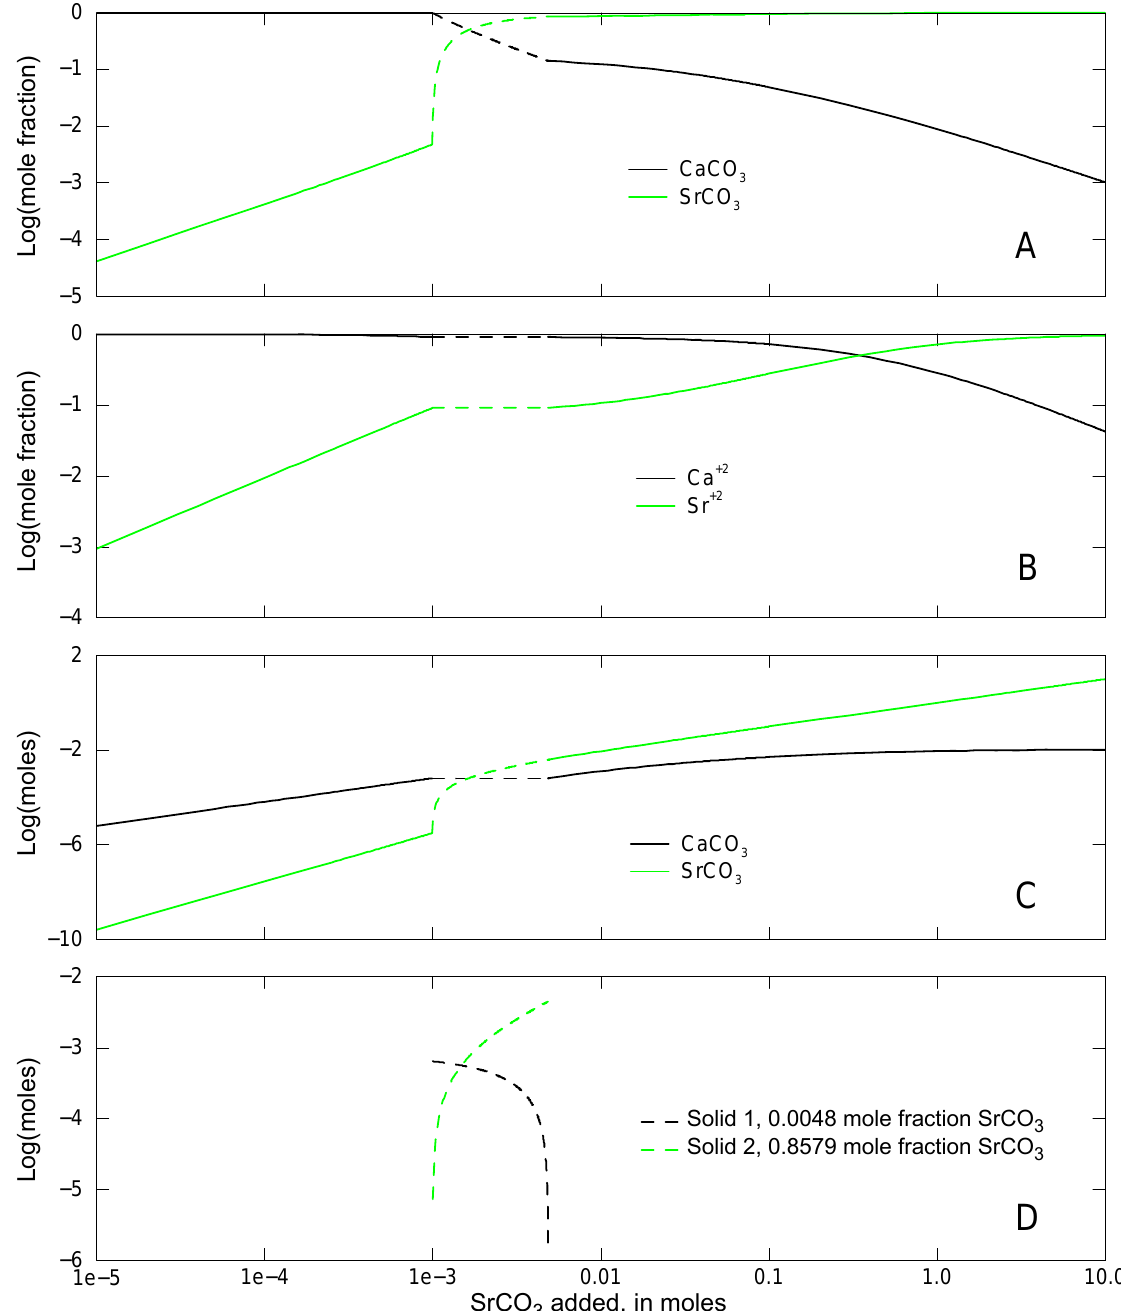
Figure 11. (A) Mole fraction of strontianite and aragonite in solid solution, (B) mole fraction of calcium and strontium in aqueous phase, (C) moles of strontianite and aragonite in solid solution, and (D) moles of miscibility-gap end members in solid solution, as a function of the amount of strontium carbonate added. Dashed lines indicate compositions within the